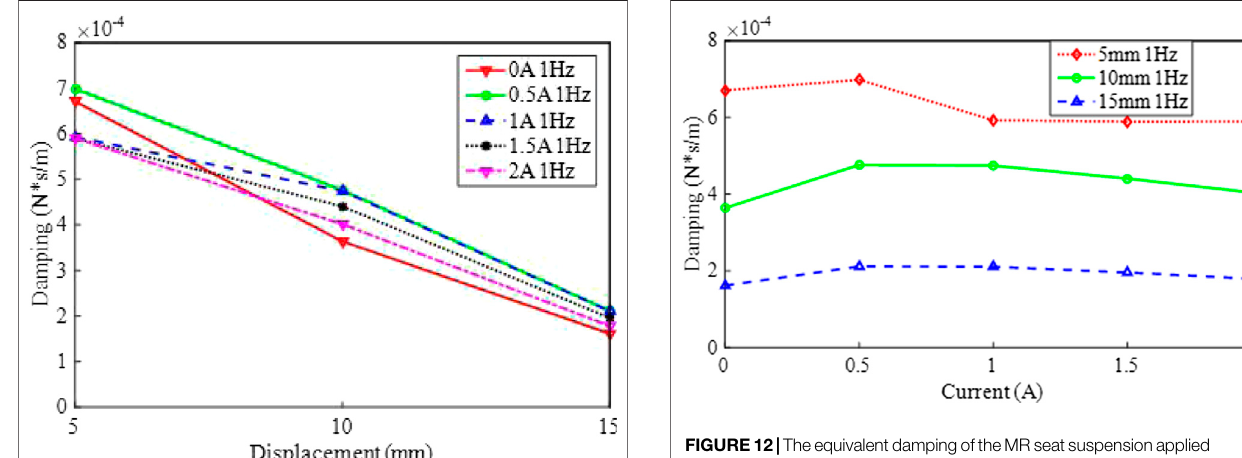
FIGURE12| TheequivalentdampingoftheMRseatsuspensionapplied with different